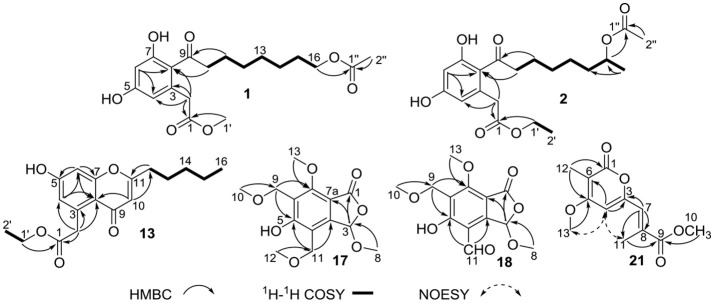
Key HMBC, 1H-1H COSY, and NOESY correlations of compounds 1–2, 13, 17–18, and 21.